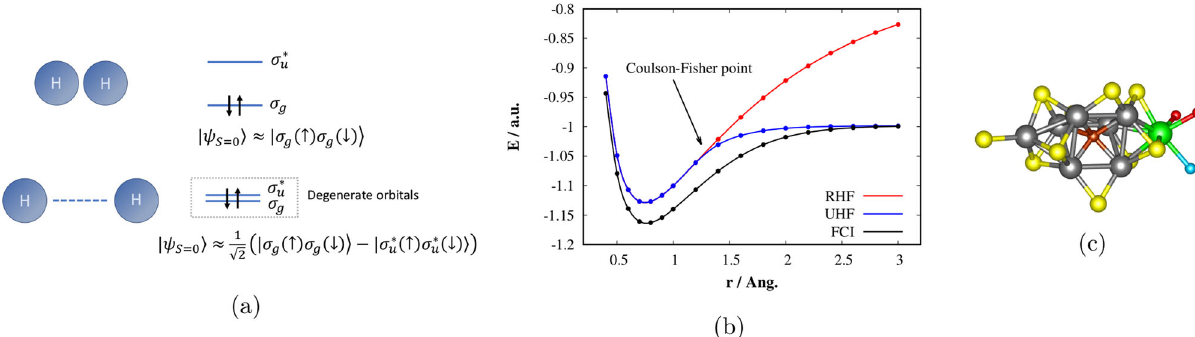
Fig. 3 Complexity of the electronic structure of strongly correlated molecules. a The bond breaking process in H 2 molecule as an example of the simplest strongly correlated problem, b comparison of restricted HF (RHF), unrestricted HF (UHF), and exact (FCI) ground state potential energy curves of H 2 in cc- pVDZ basis, c Structure of the FeMoco cluster 9 , atom colors: nitrogen — blue, sulfur — yellow, oxygen — red, carbon — brown, iron — gray, molybdenum